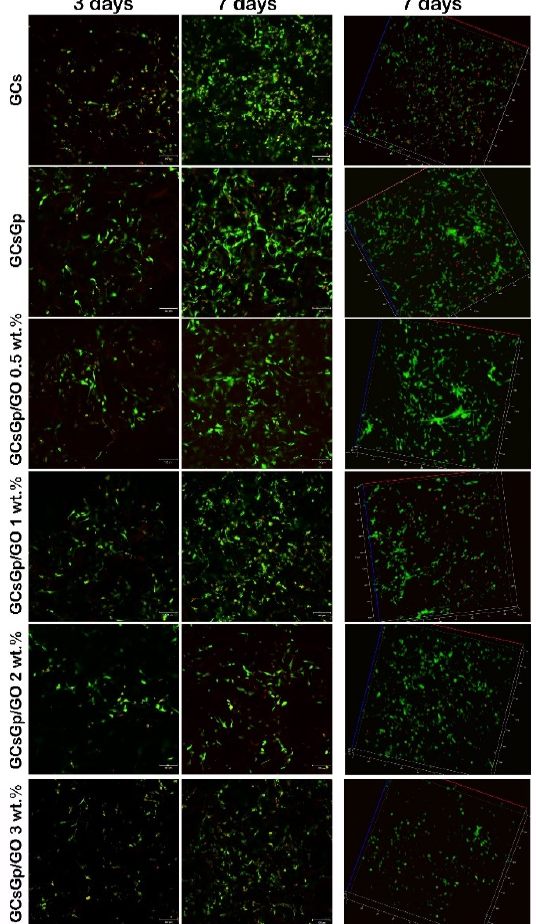
Figure 7. Fluorescence microscopy evaluation of living (green-labeled) and dead (red-labeled) cells in contact with GCs and GCsGp/GO scaffolds during one week of in vitro cell culture.